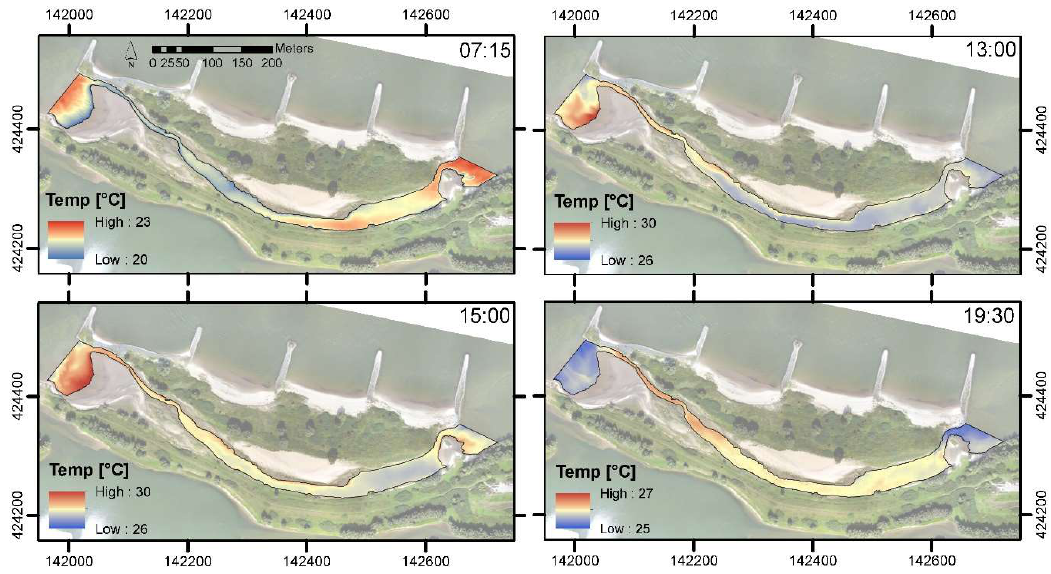
Figure 5. Temperature maps of the side channel in the floodplain of the river derived from uncorrected thermal imagery (°C, T UAV ) during the morning (07:15), mid-day (13:00 and 15:00) and evening (19:30). Note the different color scales across the individual maps.